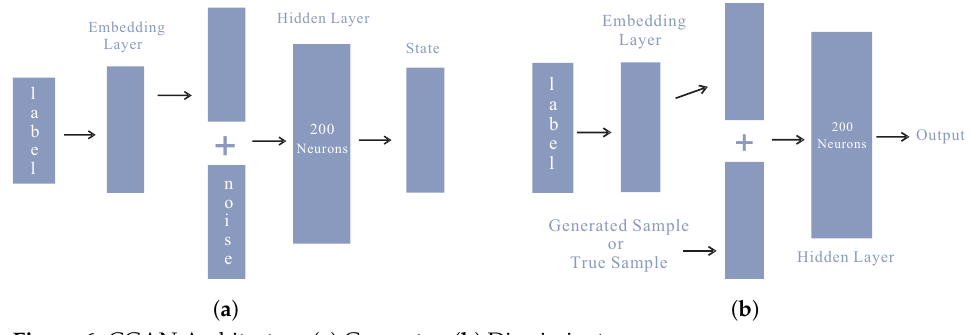
Figure 6. CGAN Architecture ( a ) Generator, ( b )